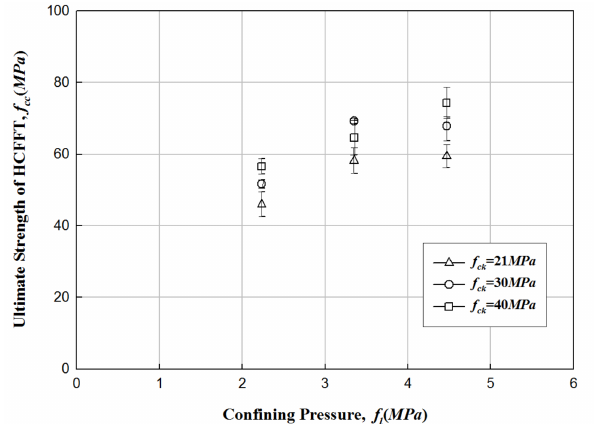
Figure 17. Average compressive strength of hybrid − CFFT with respect to the increase in the confine- ment